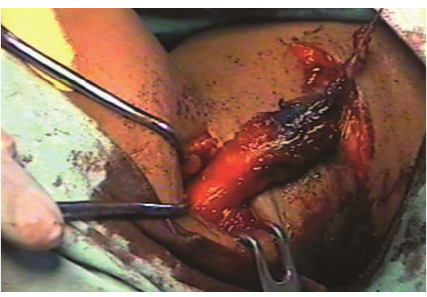
Figure 3: Excision of third branchial fistula.